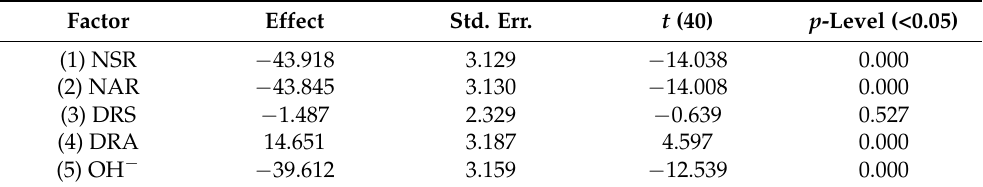
Table 6. Multiple regression analysis for compressive strength and molecular composite ion of SCSGPs (r 2 = 0.869). Factor Effect Std. Err. t (40)